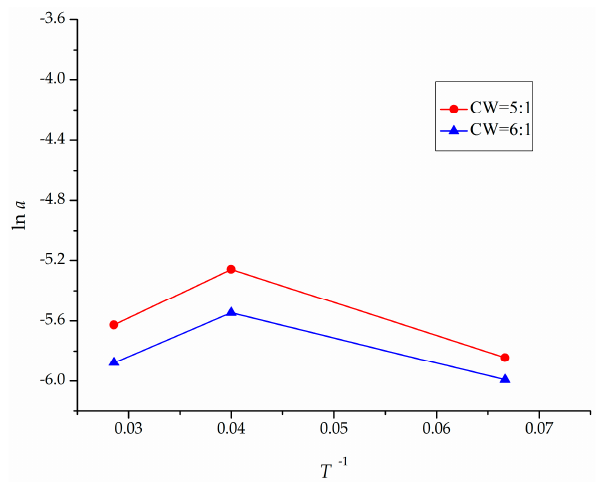
Figure 5. The lna-1/T curve.